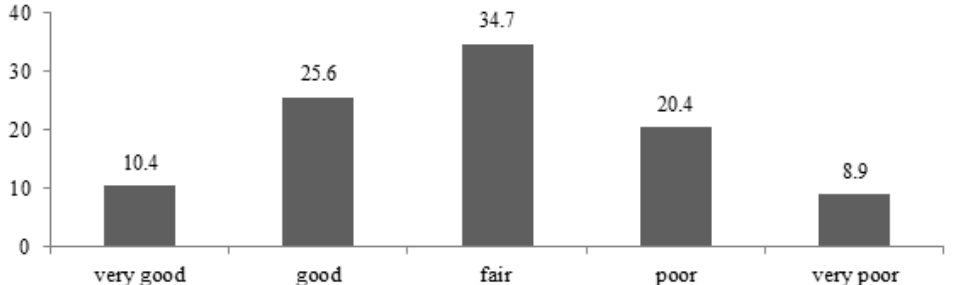
Figure 2. Percentage of satisfaction of university students with the quality of educational services of their universities.